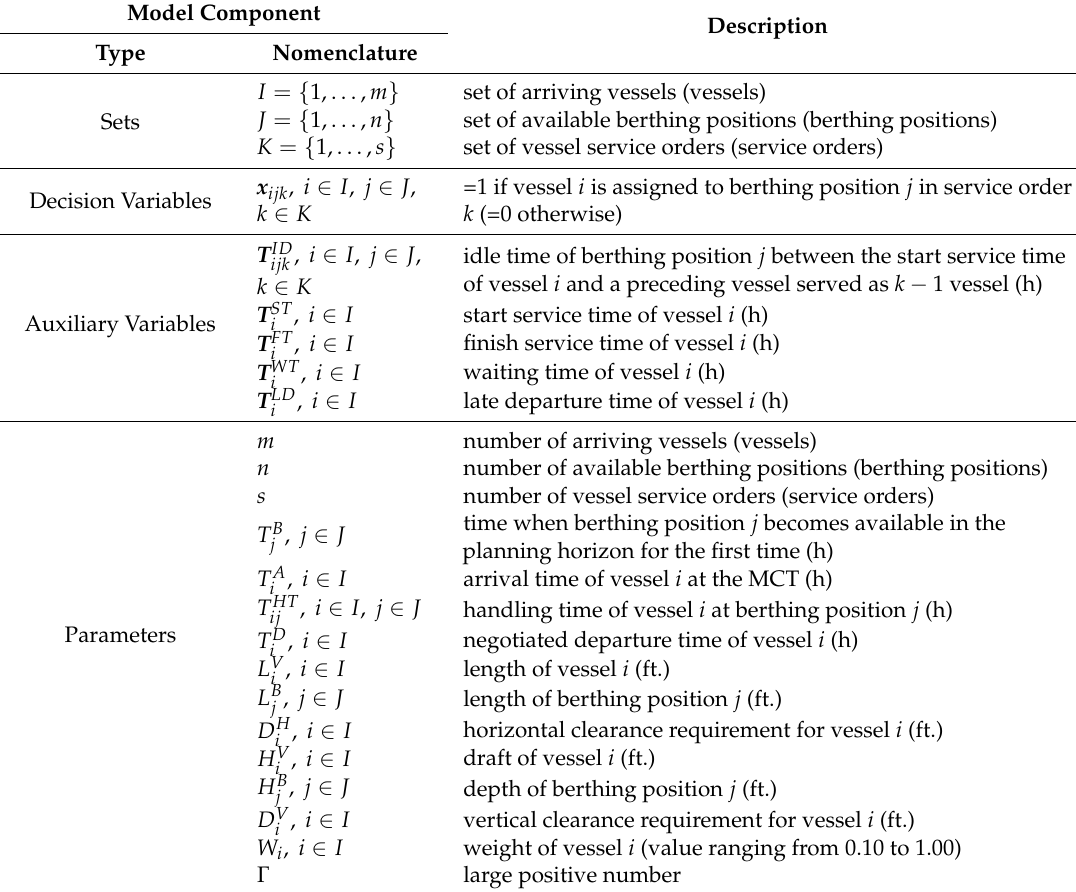
Table 1. Description of the mathematical model